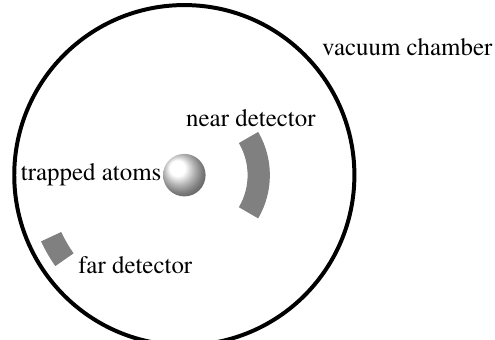
Figure 3. Schematic experimental set-up for the detection by a far detector of the reduction of s or p waves emitted by trapped atoms, in the presence of a detector close to the